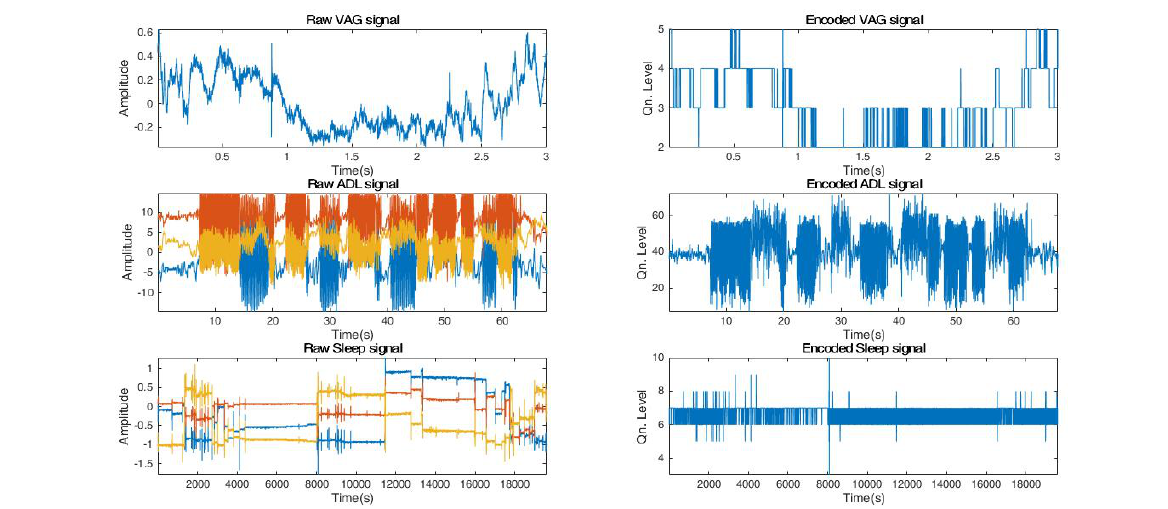
Figure 6. Sample Raw and Encoded signals from each dataset.